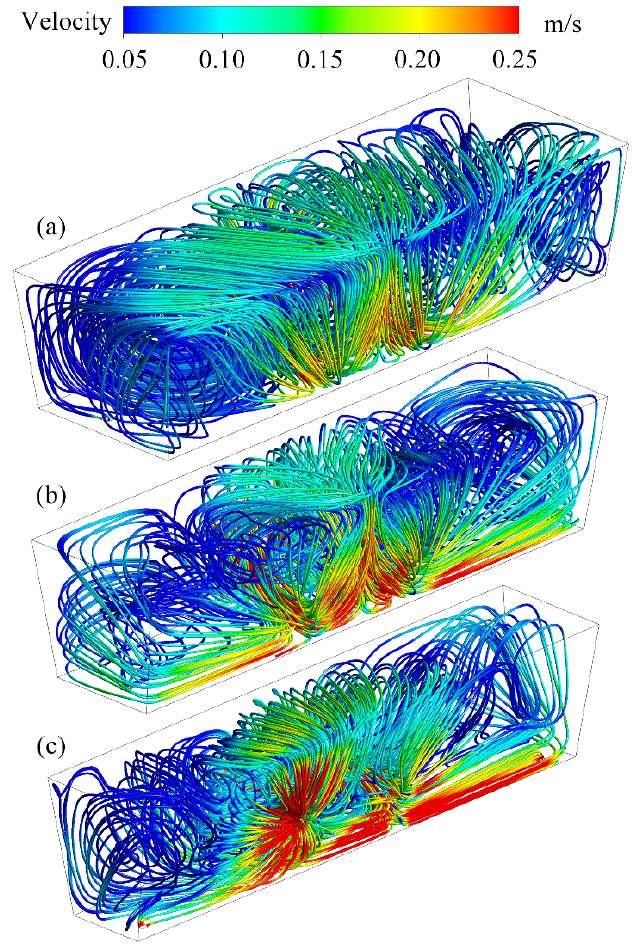
Figure 6. Streamline in distributing chambers: ( a ) tundish A, ( b ) tundish B, ( c ) tundish C.